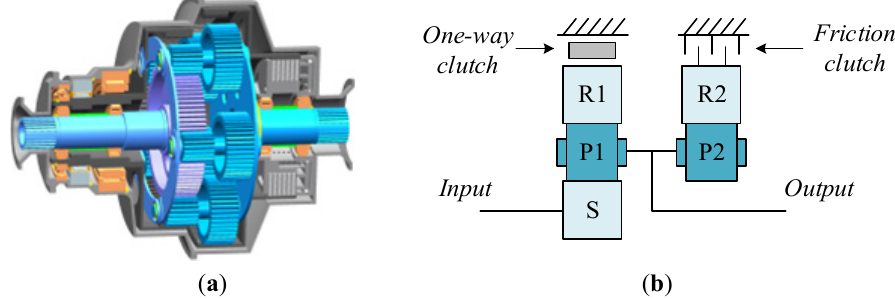
Figure 1. Double-row double planetary gearbox: ( a ) three-dimensional drawing, ( b ) structure dia- gram.